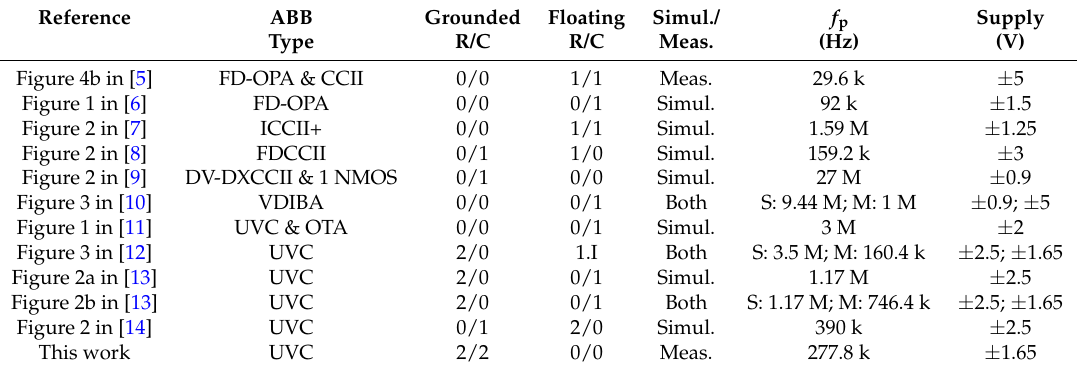
Table 1. Comparative study of existing dual-output voltage-mode (VM) all-pass filters